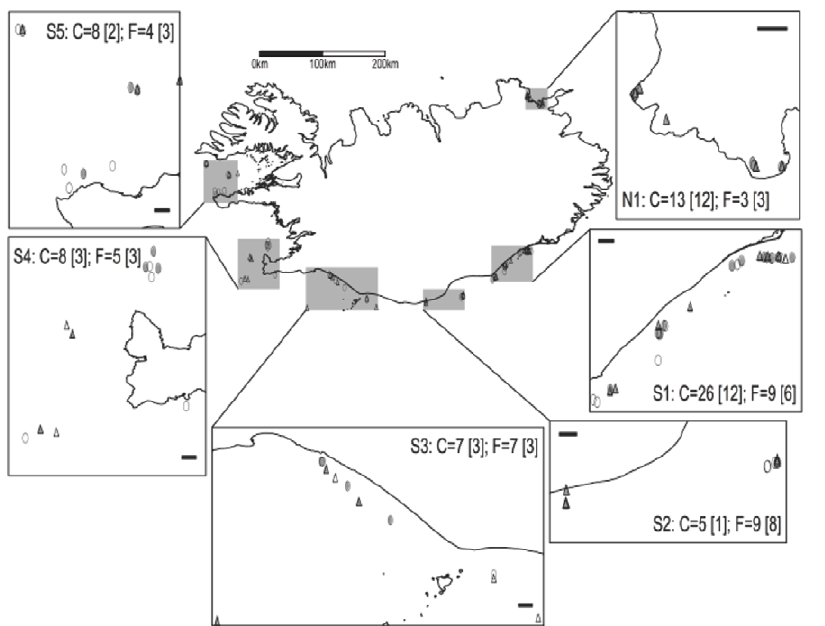
Figure 2. Original capture locations of Atlantic cod implanted with data storage tags (DSTs) around Iceland. Insets show the sampling regions in north (N1) and south (S1-S5) Iceland and indicate the number of recovered coastal (C, # ) and frontal (F, n ) individuals originally tagged and released in that area. The bracketed numbers and filled symbols represent individuals for whom spawning information could be extracted from their DST profile. Scale bar within each inset indicates a distance of 10 km.